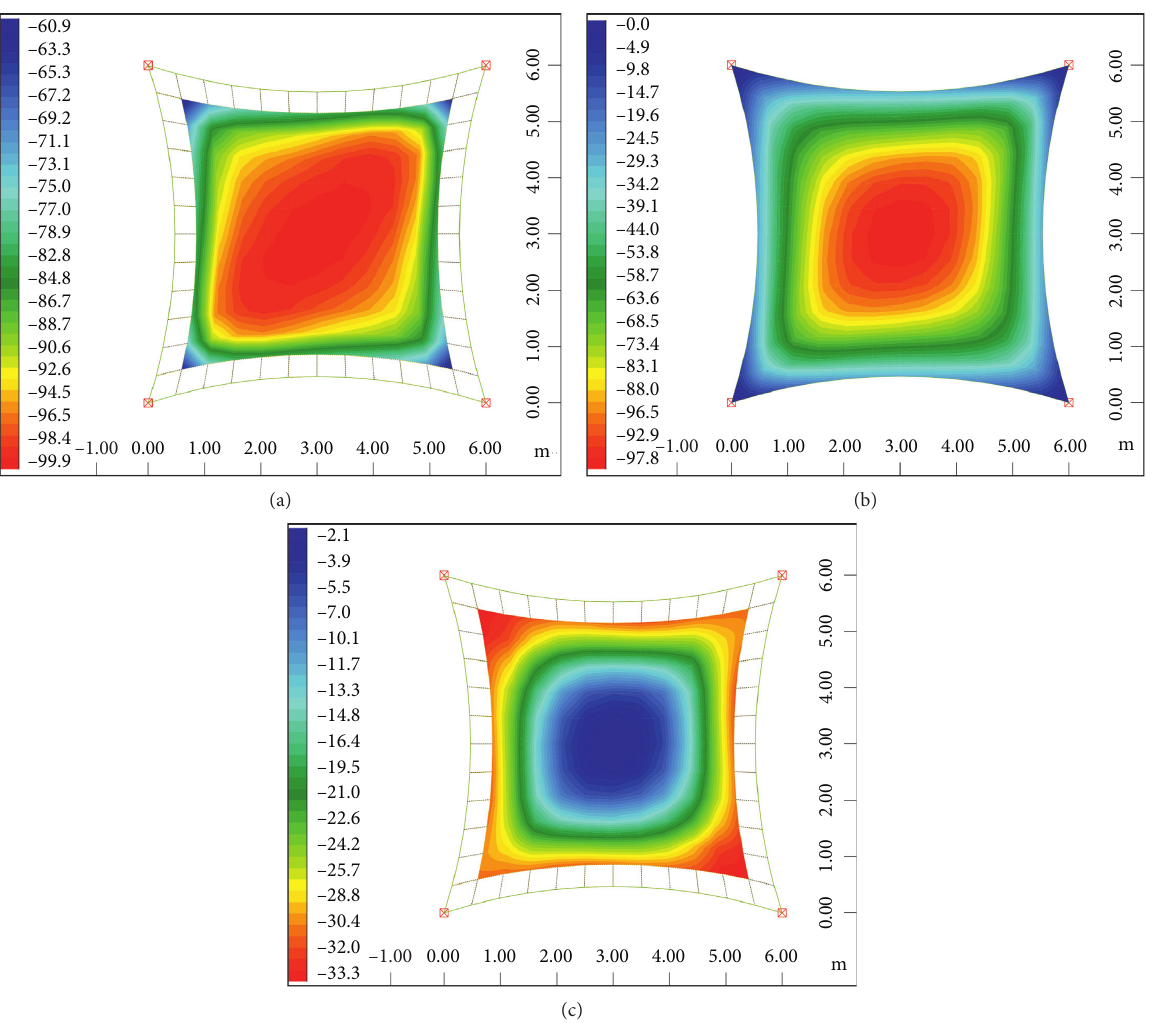
Figure 8: Comparison of deflections for one of the models (mm). (a) Sensitivity to 1kN point load. (b) Deflections for 0.6 kN/m 2 snow load. (c) Their